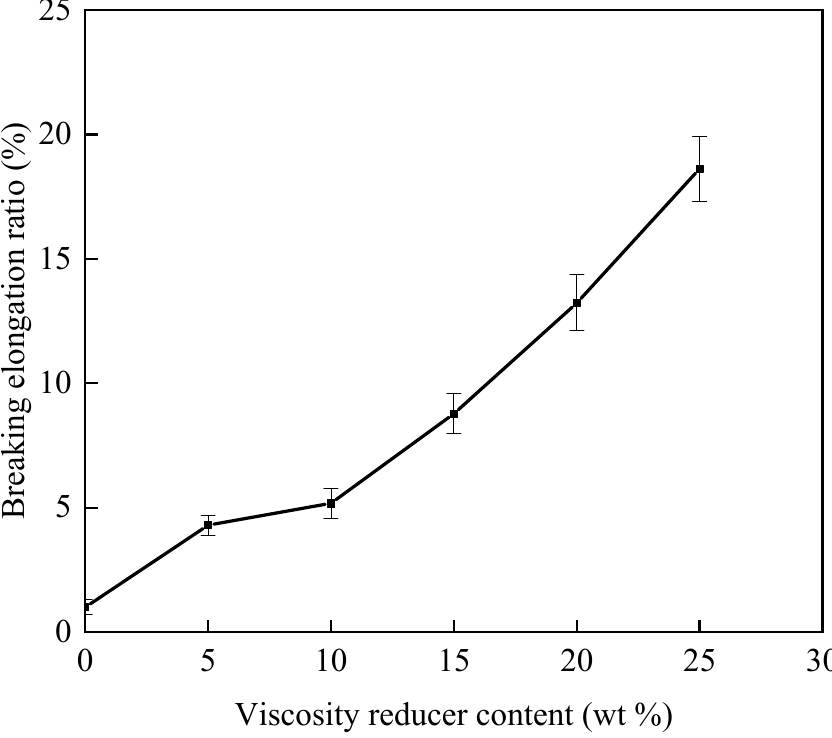
Figure 11. Change of the breaking elongation ratio of sealant.